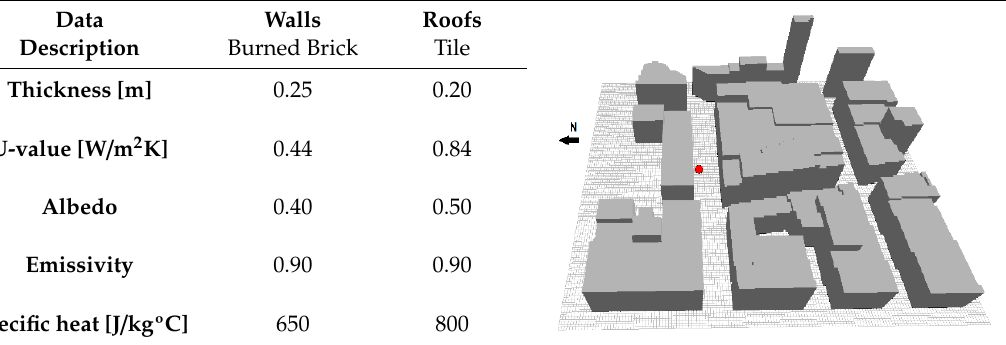
Table 3. Analysis of the current situation of the selected urban case study areas.